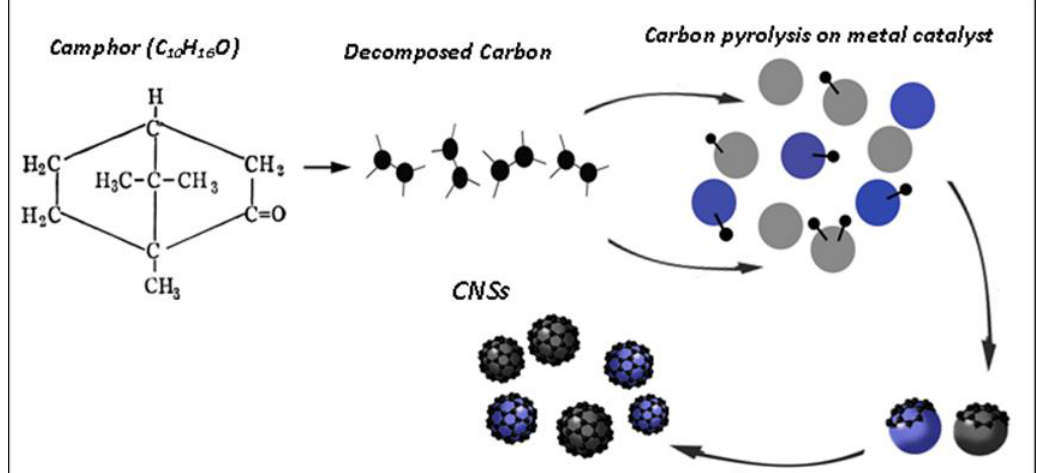
Fig. 2: Processes of catalytic CNSs growth